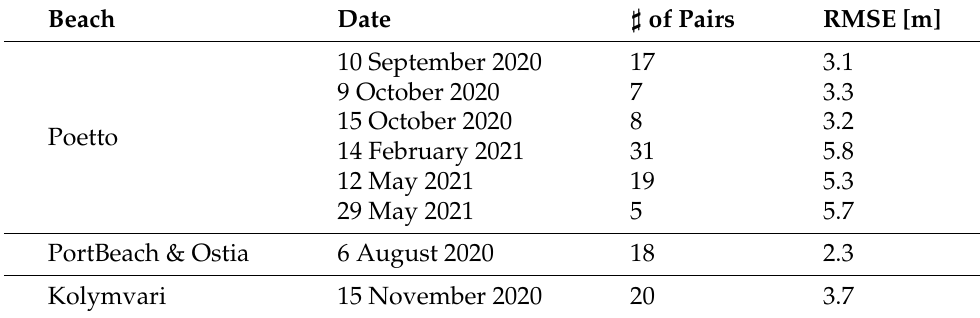
Table 4. Root Mean Square Error (RMSE) obtained for the homographies. Beach Date (cid:93) of Pairs RMSE [m]